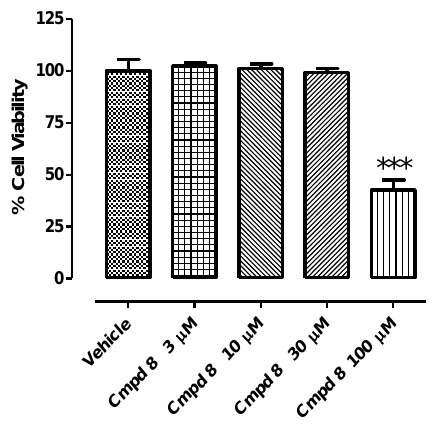
Figure 4. Concentration–response of compound 8 in H9c2 cell line after 24 h of treatment. Cell viability is expressed as percentage of the vehicle. One-way ANOVA followed by Bonferroni post-test was used for the statistical analysis. * represents the statistical significance vs. vehicle (*** p < 0.001). Bars indicate mean ± SEM.